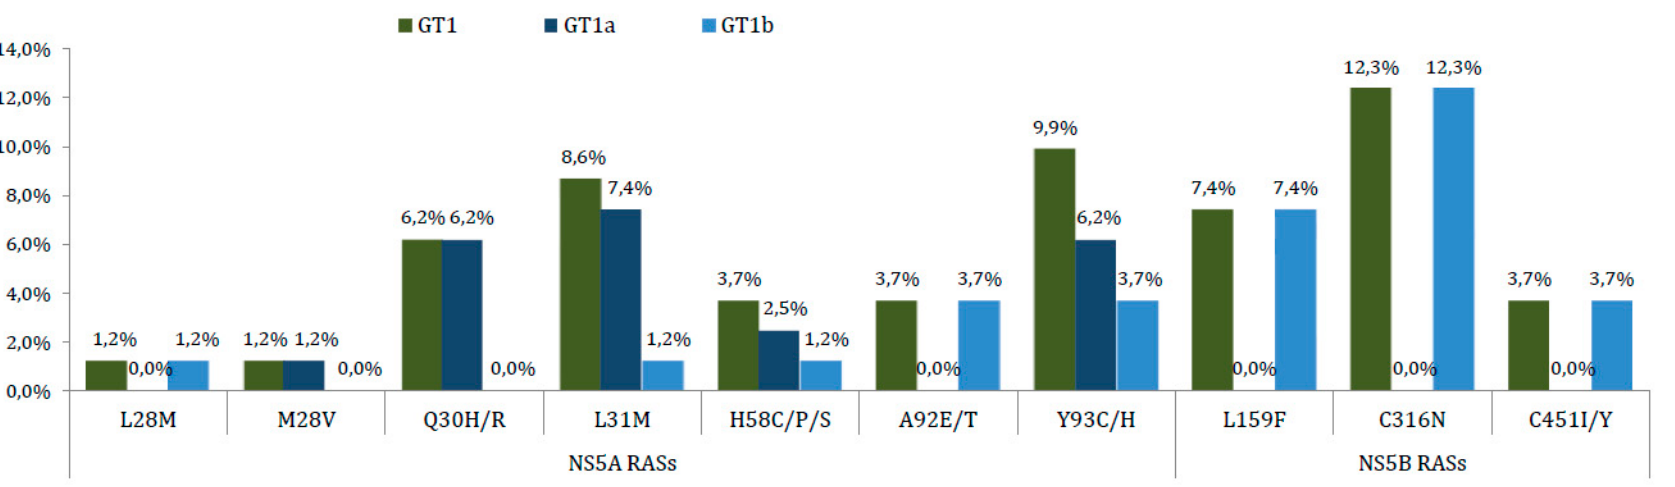
Figure 5. Baseline prevalence of specific NS5 RASs in all 81 HCV-infected patients by HCV subtype. Substitution analyses were conducted on Sanger sequencing data with a 15% cut-off limit. Dual-class RASs are assigned as NS5A + NS5B RASs.